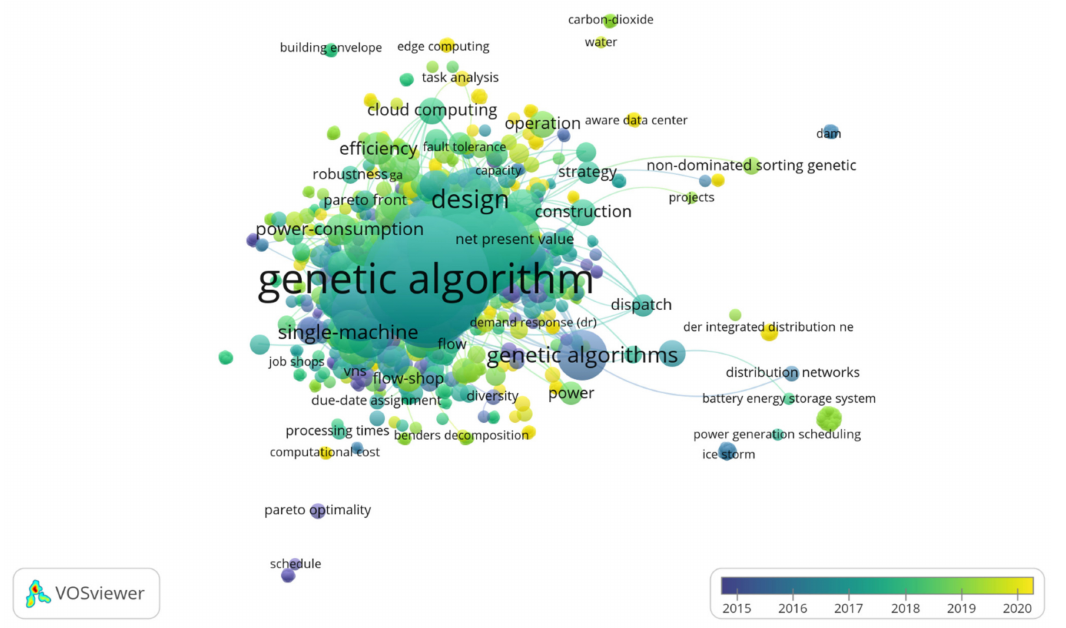
Figure 12. Overlay visualization occurrences (database: WoS https://clarivate.com accessed on